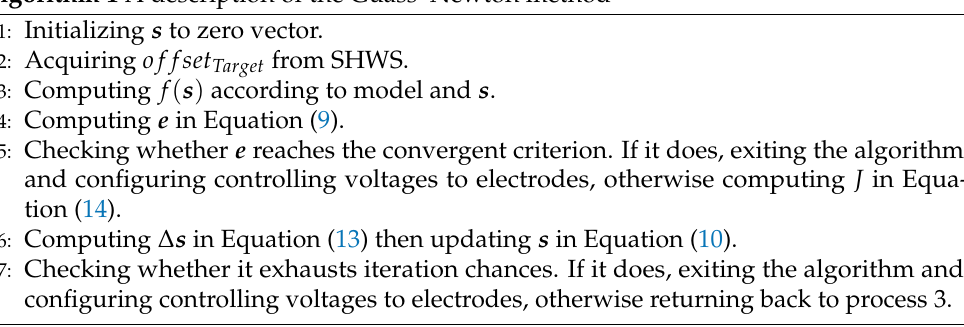
Algorithm 1 A description of the Guass–Newton